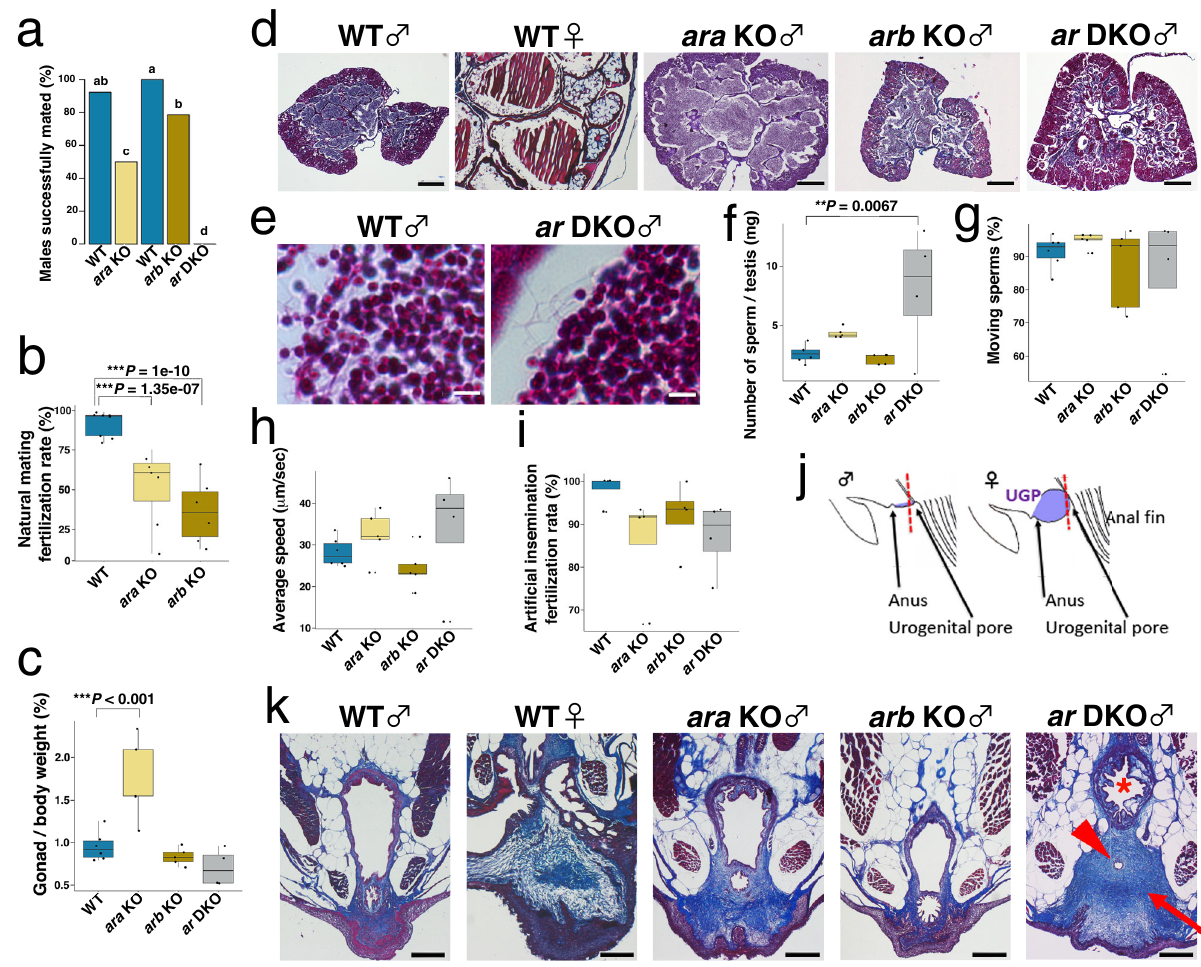
Fig. 1 | De fi ciency of either ara or arb reduces the frequency of spawning but maintains normal spermatogenesis. a Frequency of mating tests in which a WT female laid eggs within 30min after initiation of the mating. We used WT ( n =11, total60matings)and ara KOmales( n =14,total76matings)ofthesamelitter,and WT ( n =6, total 42 matings) and arb KO ( n =6, total 41 matings) of the same litter, and ar DKOmales( n =10,total43matings),asmatingpartnersfortheWTfemales. Details of mating tests utilised for this and following behavioural analyses were shown in Supplementary Table 2. Means are shown. Different letters above the boxesindicate signi fi cantlydifferentgroups( P <0.05,two-sidedFisher ’ sexacttest with Bonferroni correction: see Supplementary Table 3 for the statistical data.). b PercentageoffertilisationofovulatedoocytesfromWTfemalesinnaturalmating with WT, ara KO, and arb KO males ( n =9, 7, and 6, respectively). The P values of fertilisationratesfornaturalmating( b )andarti fi cialinsemination( i )arecalculated using two-sided Dunnett ’ s multiplecomparison in a binomialGLMM (*** P <0.001). c Gonad/bodyweightratiosofadultWT, ara KO, arb KO,and ar DKOmales( n =6,5, 5, and 4, respectively). The P values are calculated using two-sided Dunnett ’ s multiple comparison test. d Representative micrographs of Masson/trichrome- stained sections of adult gonads of WT males, WT females, ara KO males, arb KO males, and ar DKO males ( n ≥ 3 for each genotype). Scale bars represent 200 μ m. e Higher magni fi cation of Masson/trichrome-stained sections of WT testis and ar DKOtestis.Scalebarsrepresent5 μ m. f NumberofspermpertestisofadultWT, ara